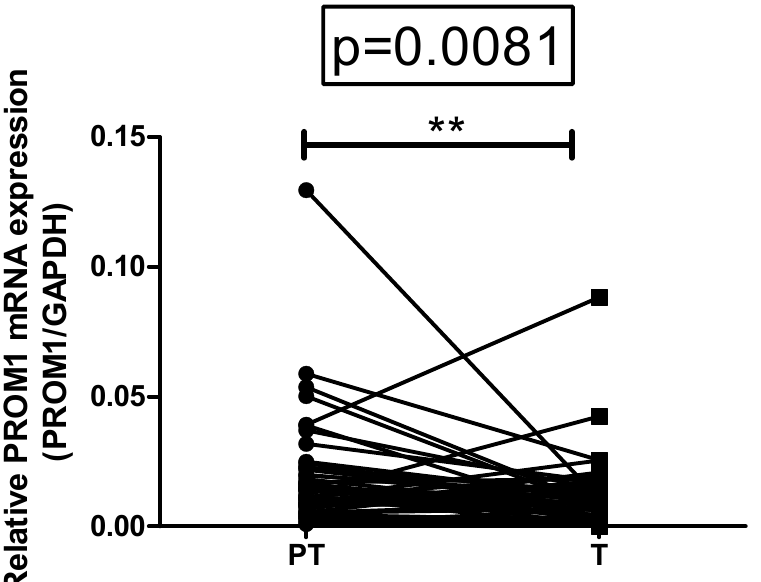
Figure 2. Comparative expression of PROM1 mRNA in paired tumor and peritumor mucosa. Data are presented as relative mRNA expression of target gene to GAPDH. Wilcoxon matched pairs signed rank test, p < 0.0001. ** The difference between the matched pairs is statistical significant.